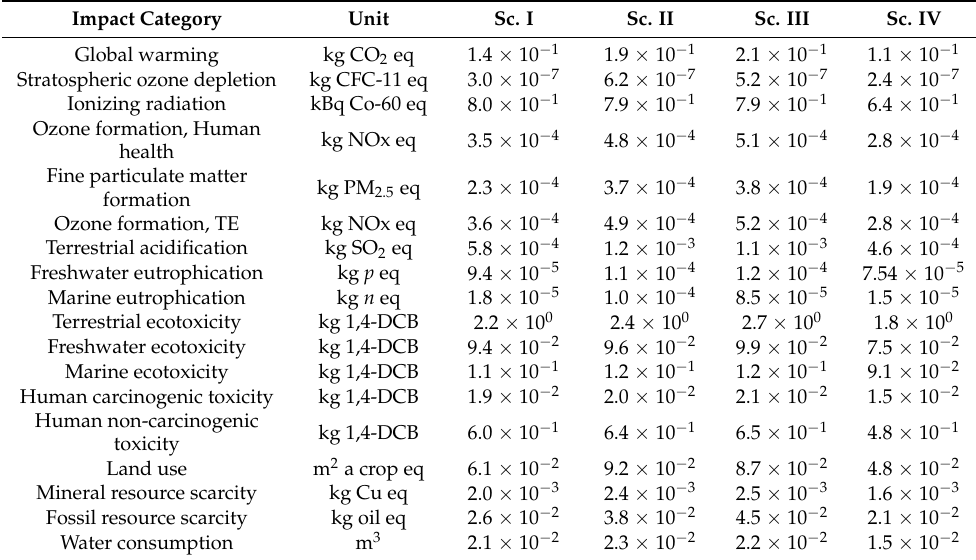
Table 2. Impact assessment results for Scenarios I, II, III and IV based on the ReCiPe midpoint impact